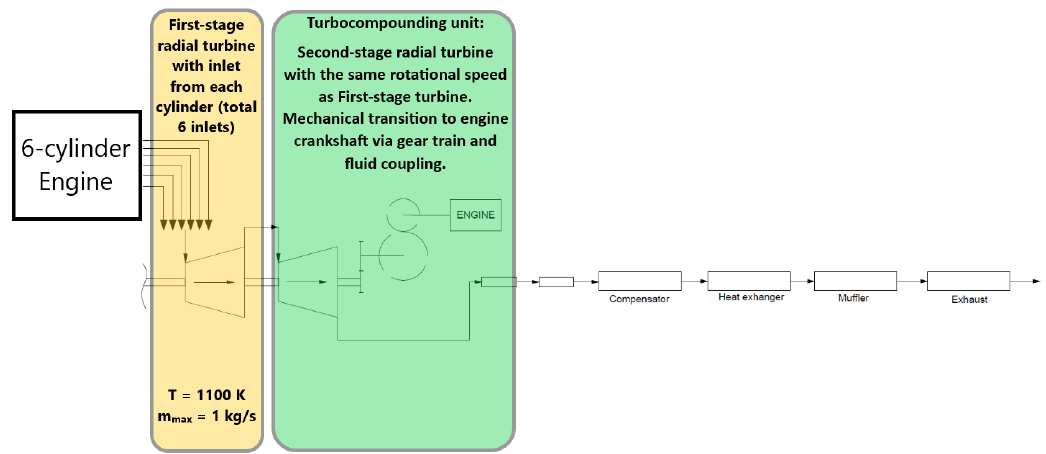
Figure 19. A schematic adaptation of two-stage turbine system for OP engine with turbocompounding unit.